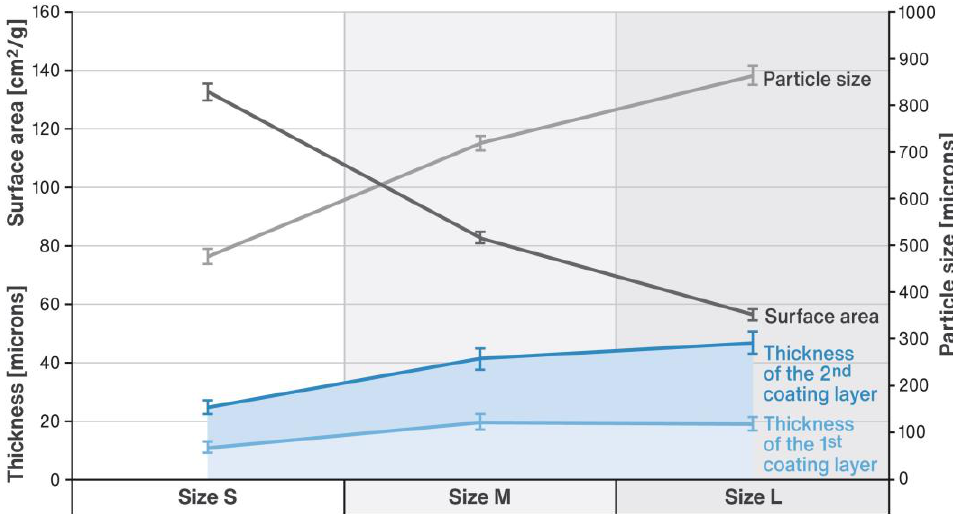
Figure 2. Relationship between RSC multiparticulate size (median CE diameter in µm), surface area (in cm 2 /g), and thickness of the coating layers (in µm); SD is indicated by the error bars.